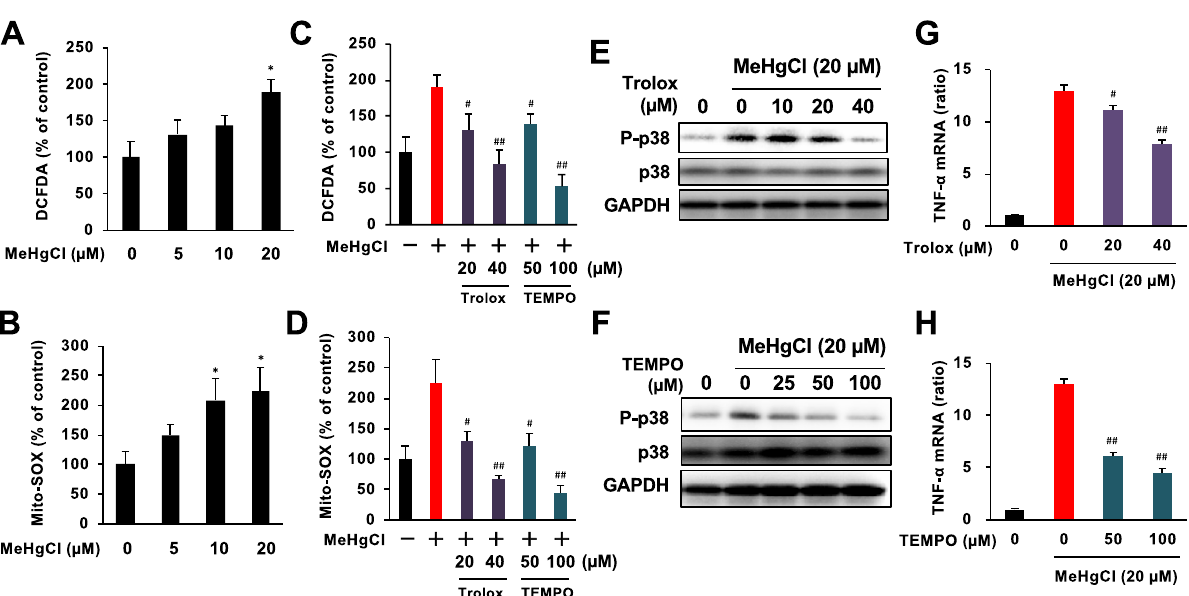
Figure 4. Effects of antioxidants on the induction of TNF-α expression by methylmercury via the ASK1/ p38 pathway in BV2 cells. BV2 cells were loaded with ( A ) 10 µM of H 2 DCF-DA or ( B ) 1 µM of Mito-SOX for 30 min. The cells were exposed to indicated concentrations of MeHgCl for 6 h and fluorescence was determined by ( A ) intracellular ROS or ( B ) mitochondrial ROS (mtROS) levels. The cells were pretreated with indicated concentrations of Trolox or Mito-TEMPO (TEMPO) for 30 min and exposed to 20 µM of MeHgCl for 6 h and fluorescence was determined by ( C ) intracellular ROS or ( D ) mtROS levels. ( E,F ) Phosphorylation of p38 was determined by Western blotting. ( G,H ) mRNA levels of TNF-α were measured by qPCR (n = 3). The data are shown as actin-corrected means ± standard deviations. The Y-axis indicates the ratio with the control as 1. * P < 0.05 vs control, * P < 0.01 vs control. # < 0.05 vs MeHgCl(+), ## < 0.01 vs